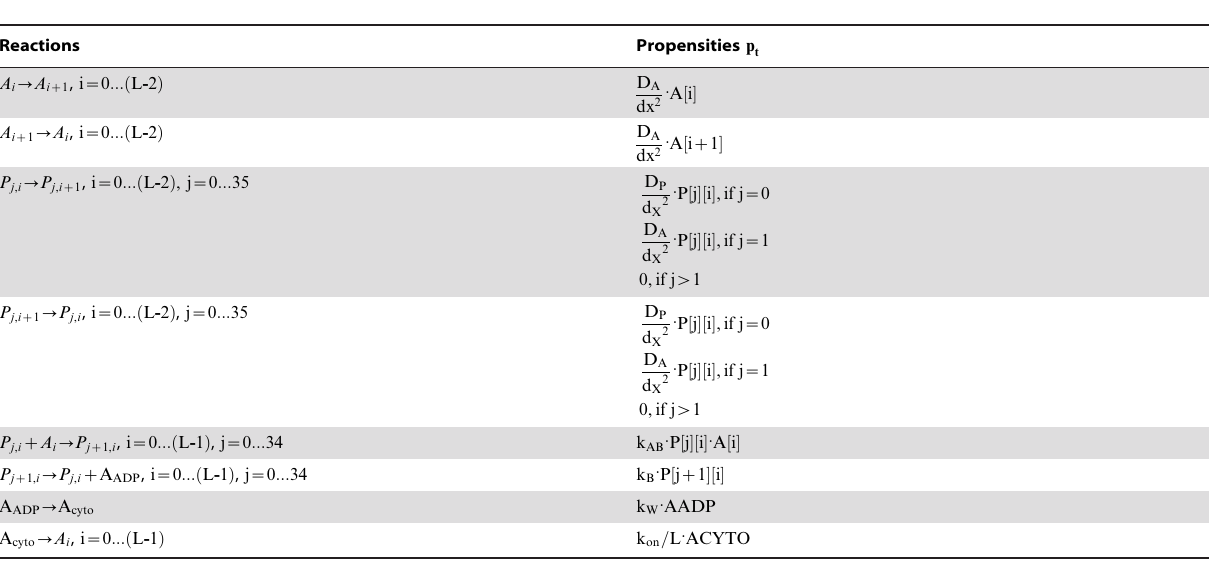
Table 1. Reactions and propensities used in the diffusion/immobilization model.